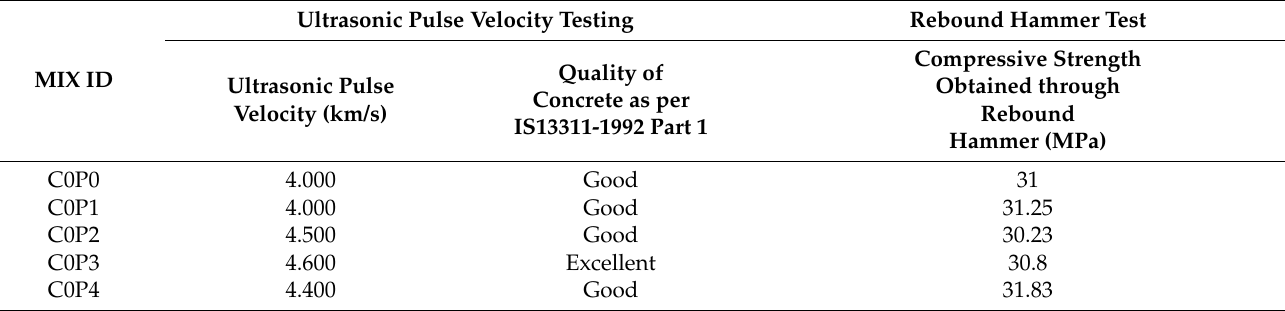
Table 8. Non-destructive testing